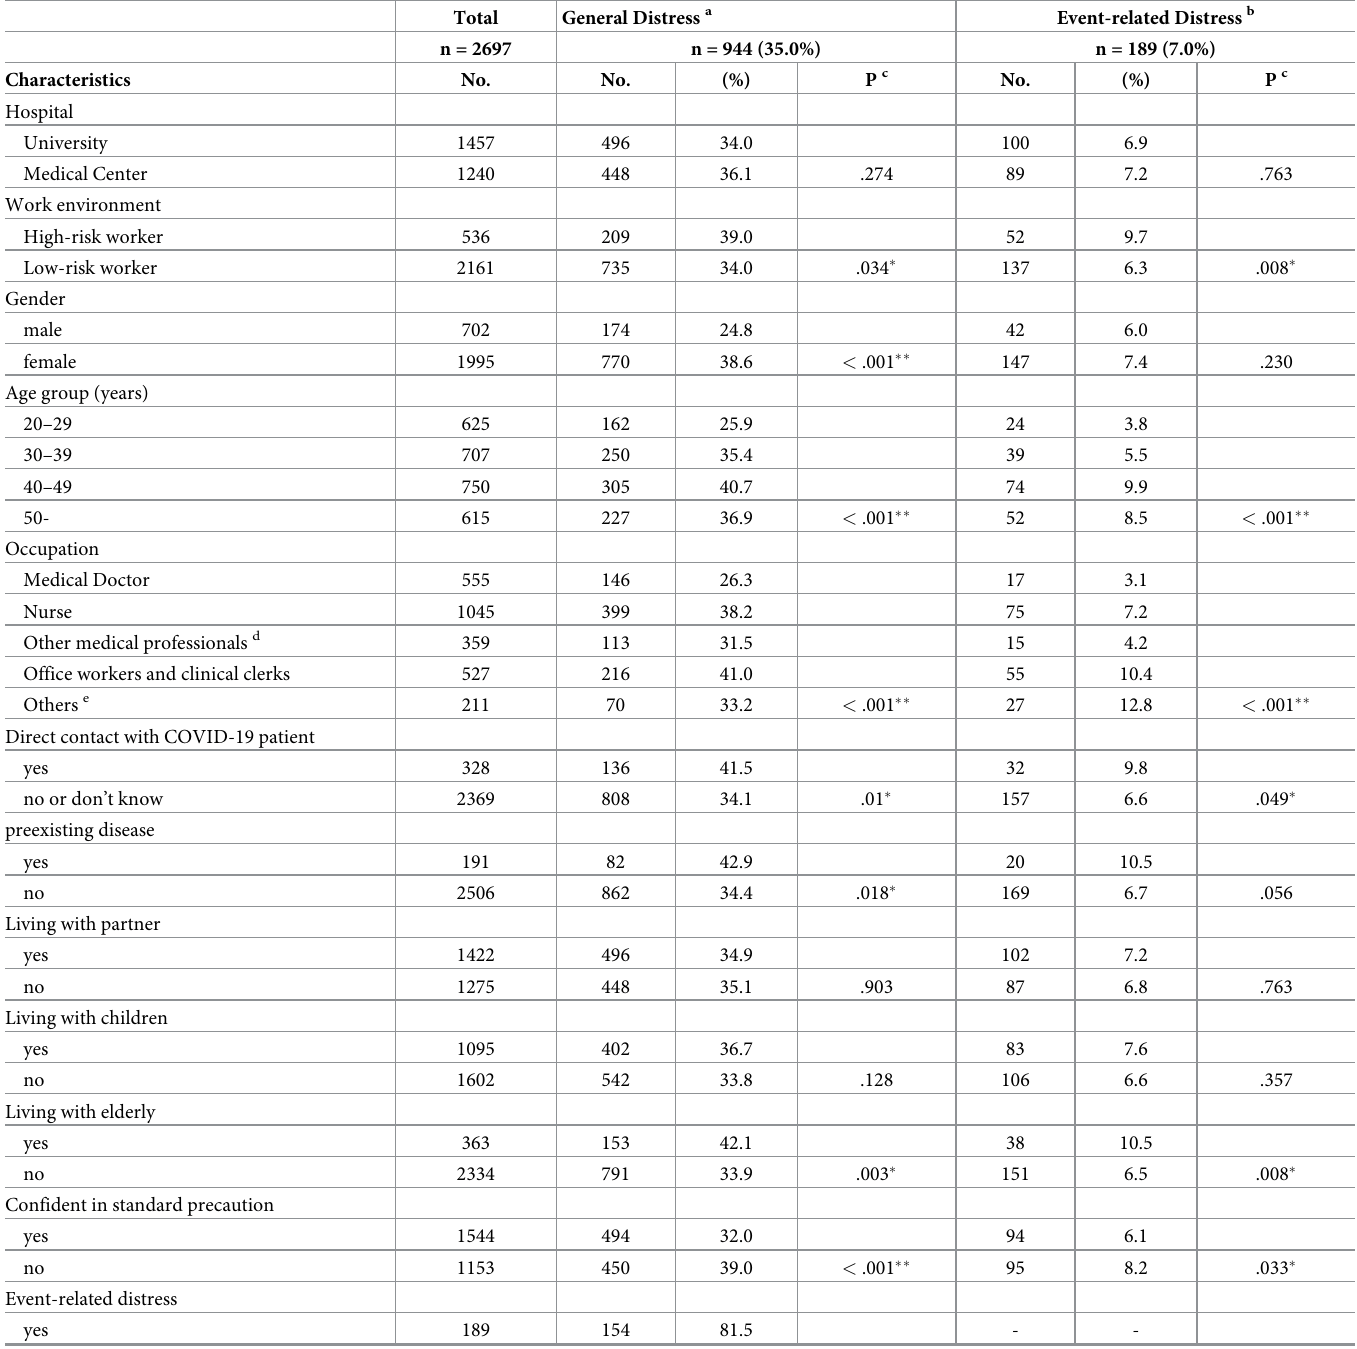
Table 2. Participants characteristics and associations with general distress and event-related